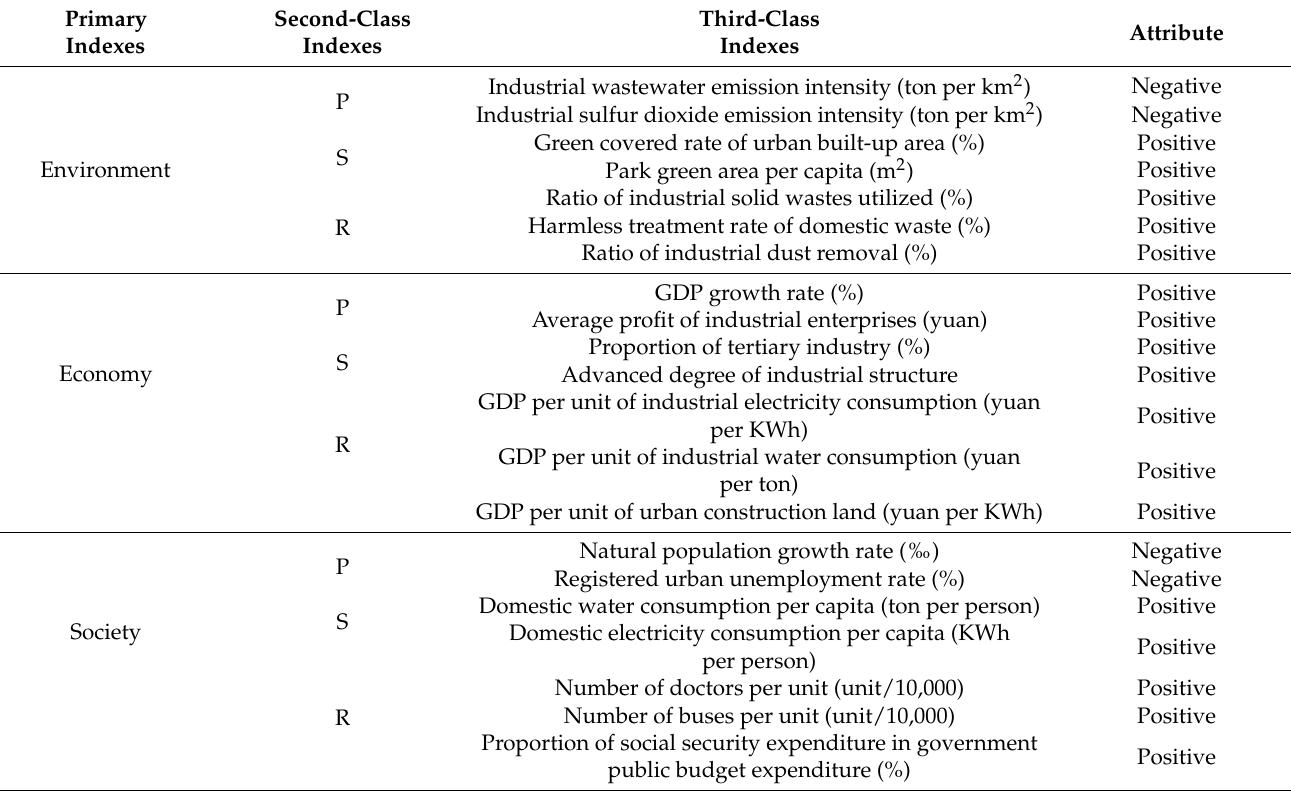
Table 1. Evaluation index system of green